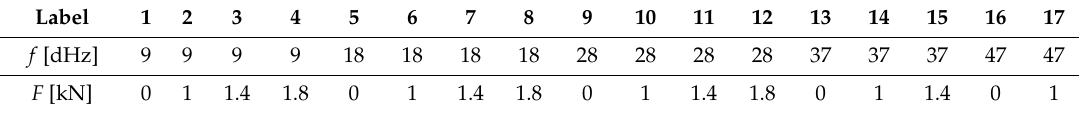
Table 4. The operational conditions: Speed and load combination.